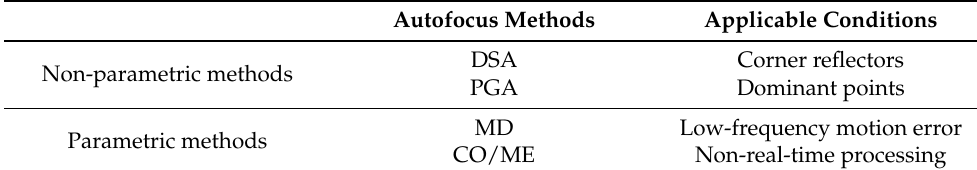
Table 1. Comparison of parametric and non-parametric autofocus methods.